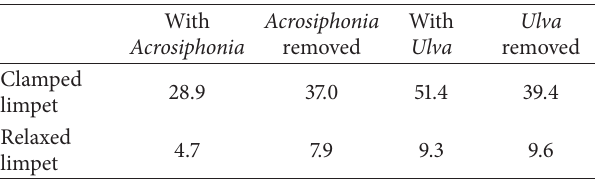
Table 2: Water velocities (m/s) required to generate sufficient drag to dislodge a clamped (25N to remove) and relaxed limpet (2N to remove). Values are predicted based on extrapolation of a nonlinear regression model.